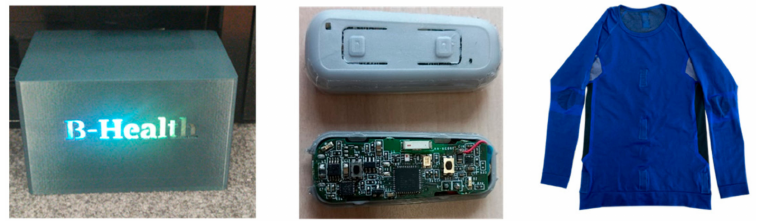
Figure 5. B-Health Box, Physiosense Posture Sensors, and